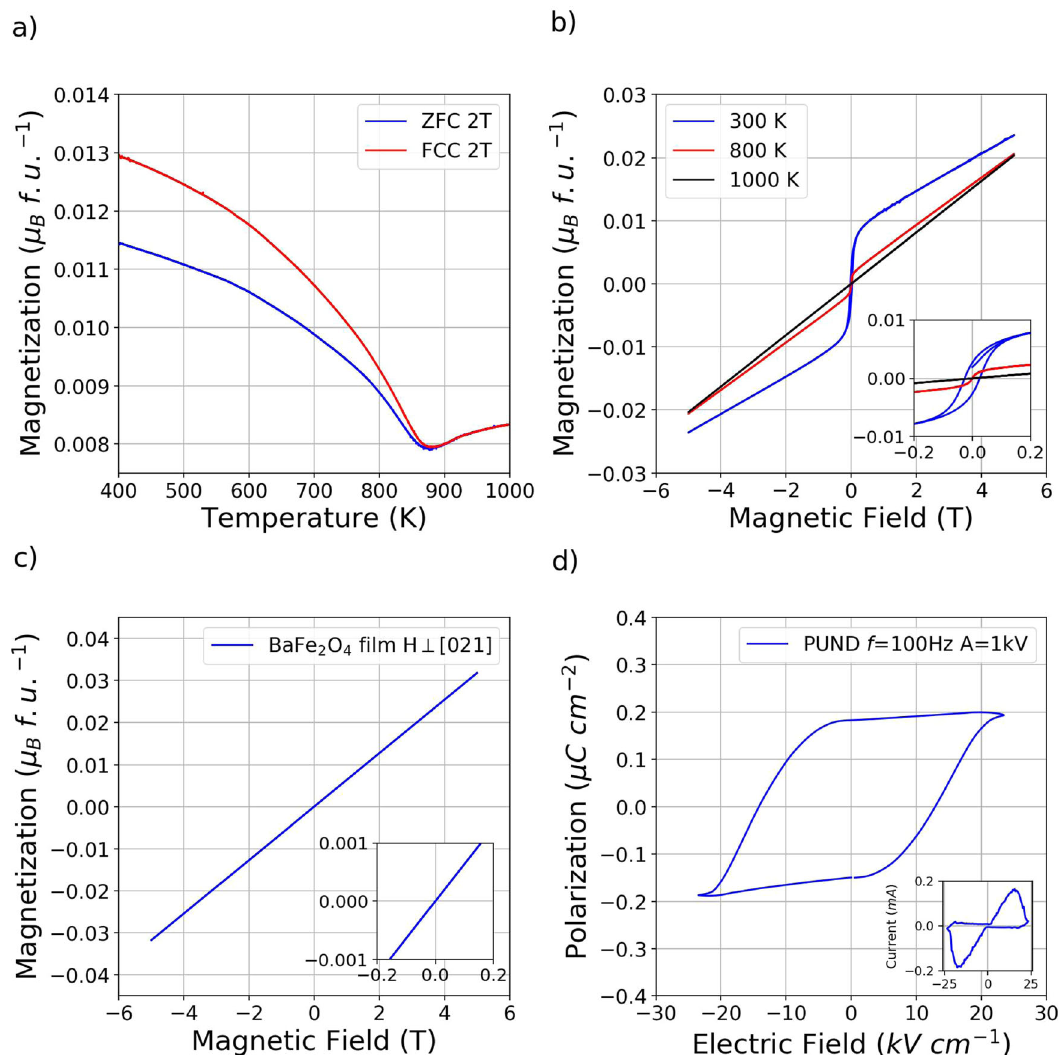
γ -BaFe 2 O 4 deposited by pulsed electron deposition on a monocrystalline silicon substratecovered by a thin layerof thermal SiO 2 . The measurement wascorrected by subtracting the diamagnetic signal of the substrate, additional information and plots of the raw data can be retrieved in the Supporting Information. The linear behavior without hysteresis and null coercive fi eld agree with the neutron data which indicate an antiferromagnetic structure without ferromagnetic component. d PN electric polarization loop collected at a frequency f =100Hz with triangular pulse of amplitude 1000V. The inset shows the corresponding integrated current as a function of the applied voltage. The clear, symmetric current peaks reinforce the conclusion of a switchable polarization in the